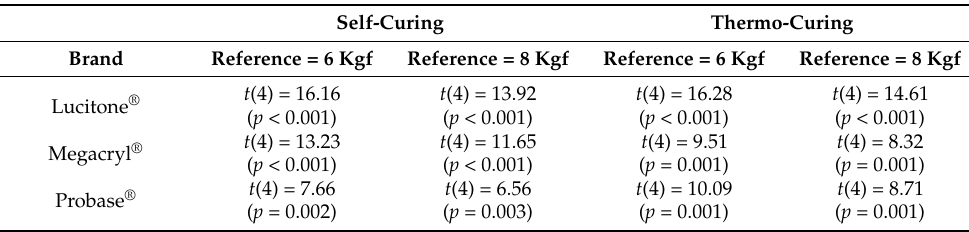
Figure 11. Box and line diagrams for the distribution of fracture torque by brand and type of resin (6 and 8 Kgf comparison). Table 3. Results of t -tests for the comparison of fracture torque with the reference limits of 6 and 8 Kgf.